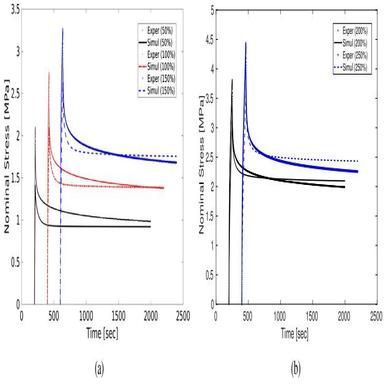
Model validation for relaxation data: (a) with the model for 50%, 100% and 150% strains, (b) with the model for 200% and 250% strains.